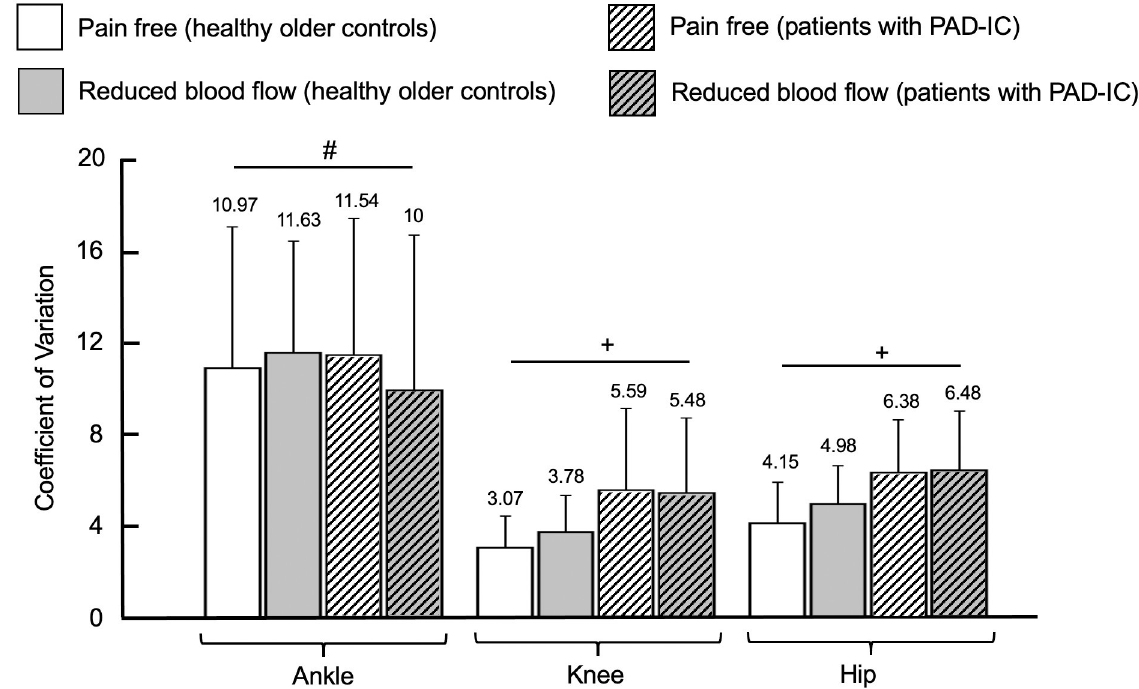
Fig 2. Coefficient of variation for healthy older controls and for patients with Peripheral Artery Disease with Intermittent Claudication (PAD-IC) in the pain free and reduced blood flow conditions for ankle, knee, and hip ranges of motion. � indicates significant differences between conditions (pain free vs. reduced blood flow, p < 0.05). + indicates significant differences between groups (healthy older controls vs PAD-IC, p < 0.05). # indicates post-hoc tests where significant interaction exists between groups and conditions. Bar graphs represent the mean values and error bars represent the standard deviation. Mean value for each bar was mentioned at the top of the corresponding error bar.